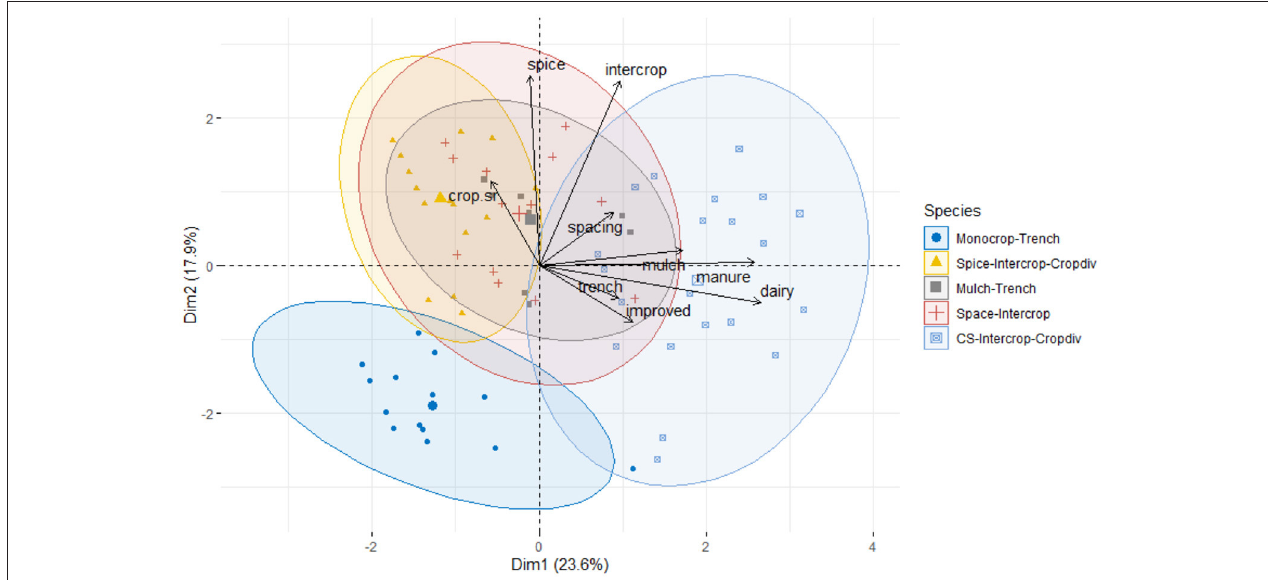
FIGURE 2 | PCA Biplot of Farm clusters, where five categories based on the dominant set of management activities emerged. First two axis indicates clear distinction between Monocrop-Trench and CS-Intercrop-Cropdiv. Third axis (not visible) distinguishes between the other three categories.